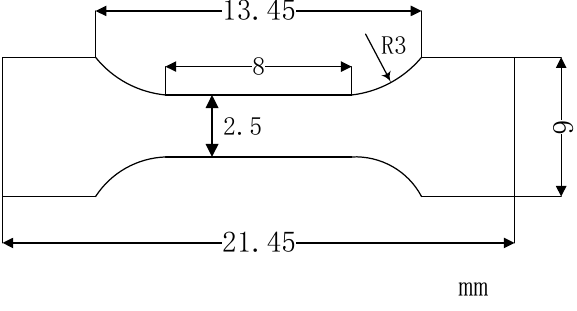
Figure 3. Schematic geometry of tensile specimen.